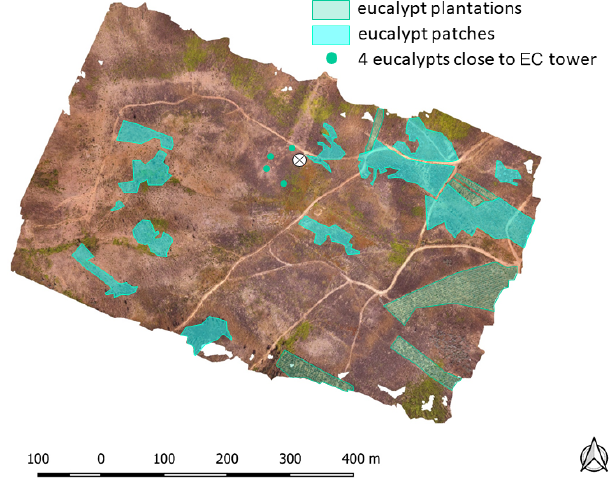
Figure 2. Ortho-photomap of the study area showing the eucalypt stands as well as the four individual eucalypt specimens close to the slim tower (EC tower; circle with cross). The rest of the area con- sists of maritime pine stands. The imagery was acquired on 18 July 2018, using a standard RGB camera mounted on a DJI Phantom 3 drone. Figure 3. Wind rose of the study area over the first post-fire hy- drological year (1 October 2017–30 September 2018), based on the sonic anemometer measurements at 11.6m